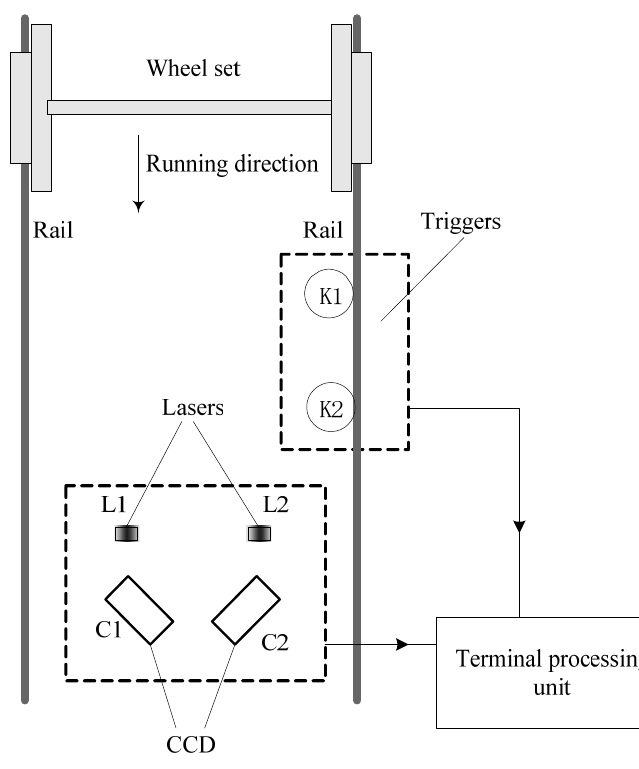
Figure 5. Schematic diagram of measurement